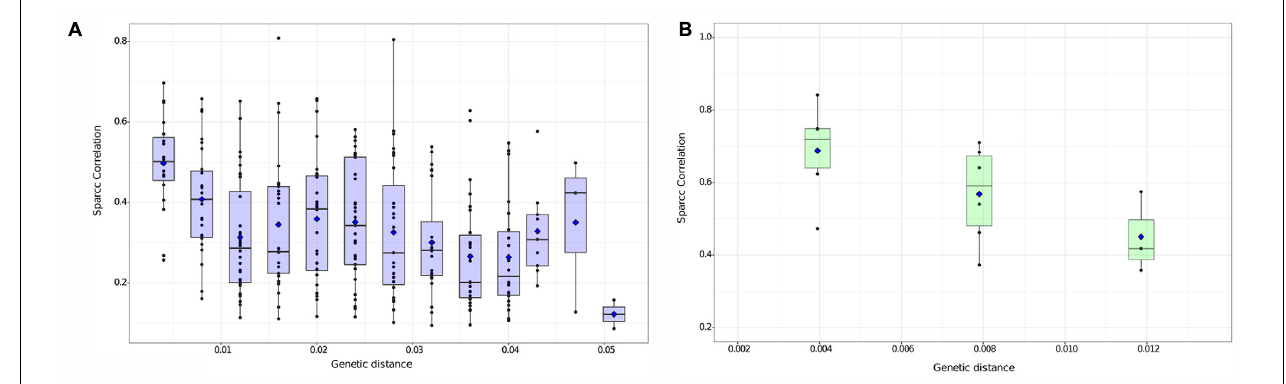
FIGURE 3 | Co-occurrence of strains declines with their pairwise genetic distance. Relationship between co-occurrence (significant SparCC correlation, P < 0.05) and genetic distance (p-distance) between Dolichospermum (A) and Microcystis (B) nodes. Blue diamonds represents the mean SparCC correlation for each distance. Boxplots show the median (horizontal line), the 25th and 75th percentile (enclosed in box) and 95% confidence intervals (whiskers). The discreteness observed in the x -axis is due to the discrete number of substitutions in the 16S rRNA gene sequence (e.g., exactly 1, 2, 3, ...nucleotide differences between